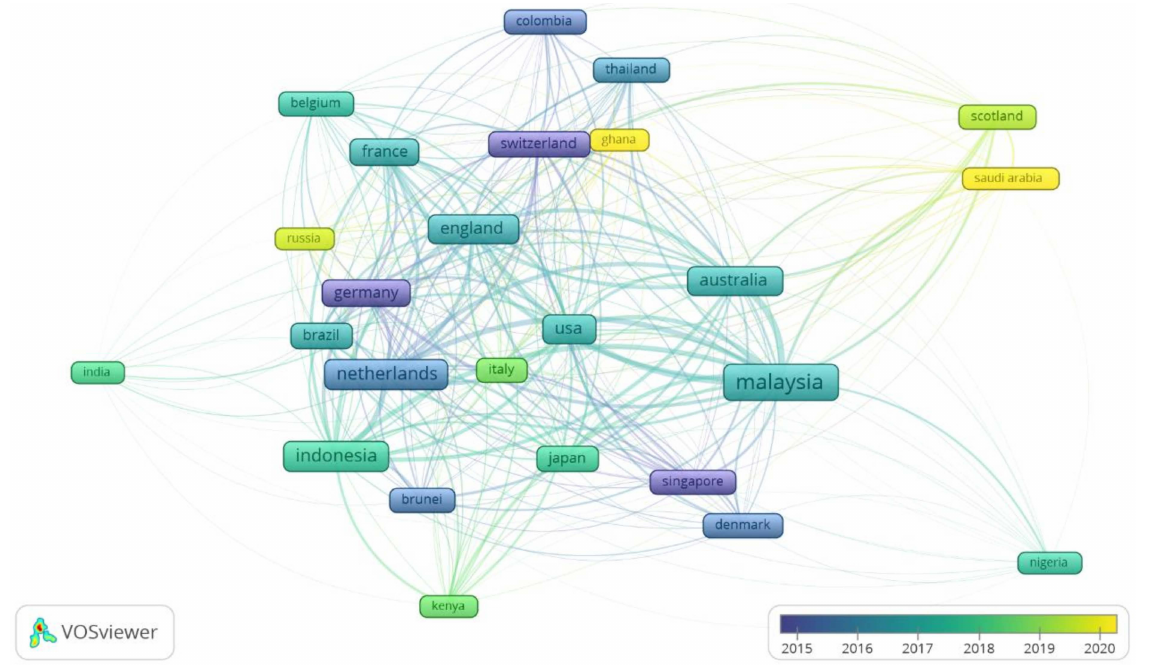
Figure 9. Bibliometric coupling